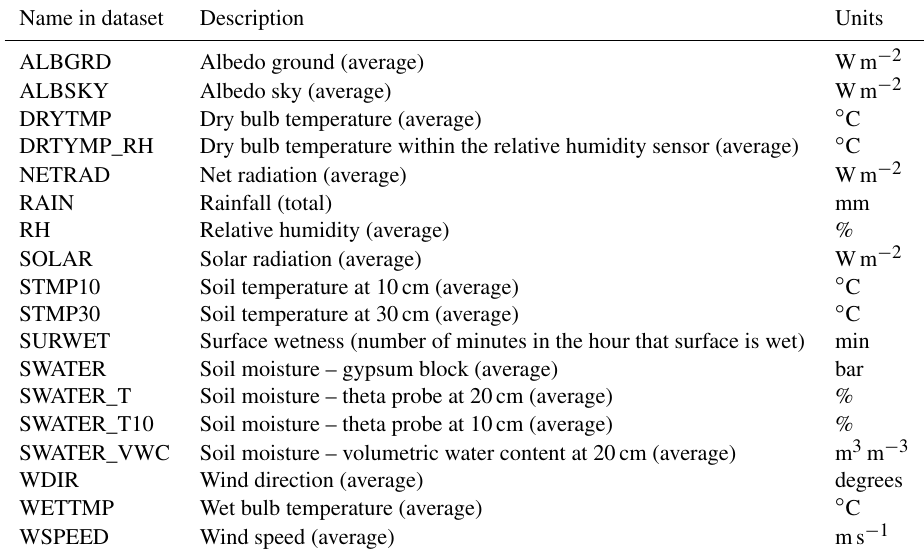
Table 3. Meteorological